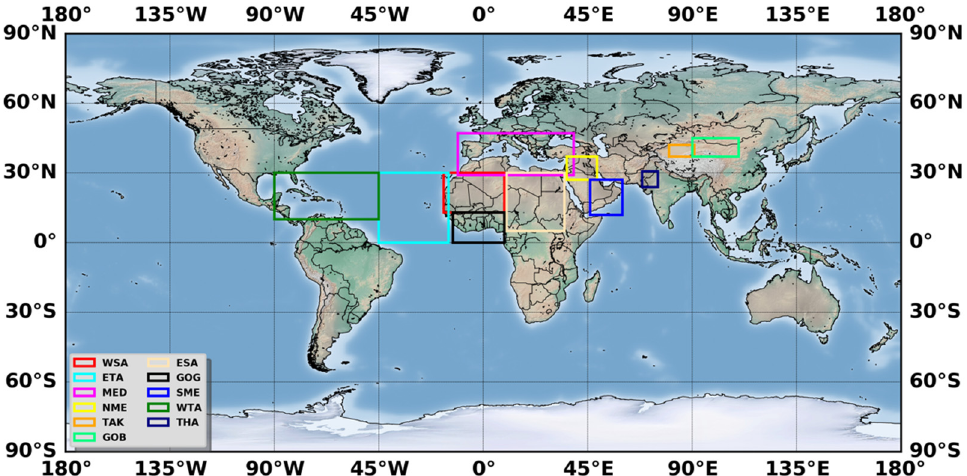
Figure 2. Geographical domains of the sub-regions considered for the regional analysis. (East Sahara (ESA), West Sahara (WSA), East Tropical Atlantic (ETA), West Tropical Atlantic (WTA), Gulf of Guinea (GOG), Mediterranean (MED), North Middle East (NME), South Middle East (SME), Thar (THA), Taklamakan (TAK), Gobi (GOB)).